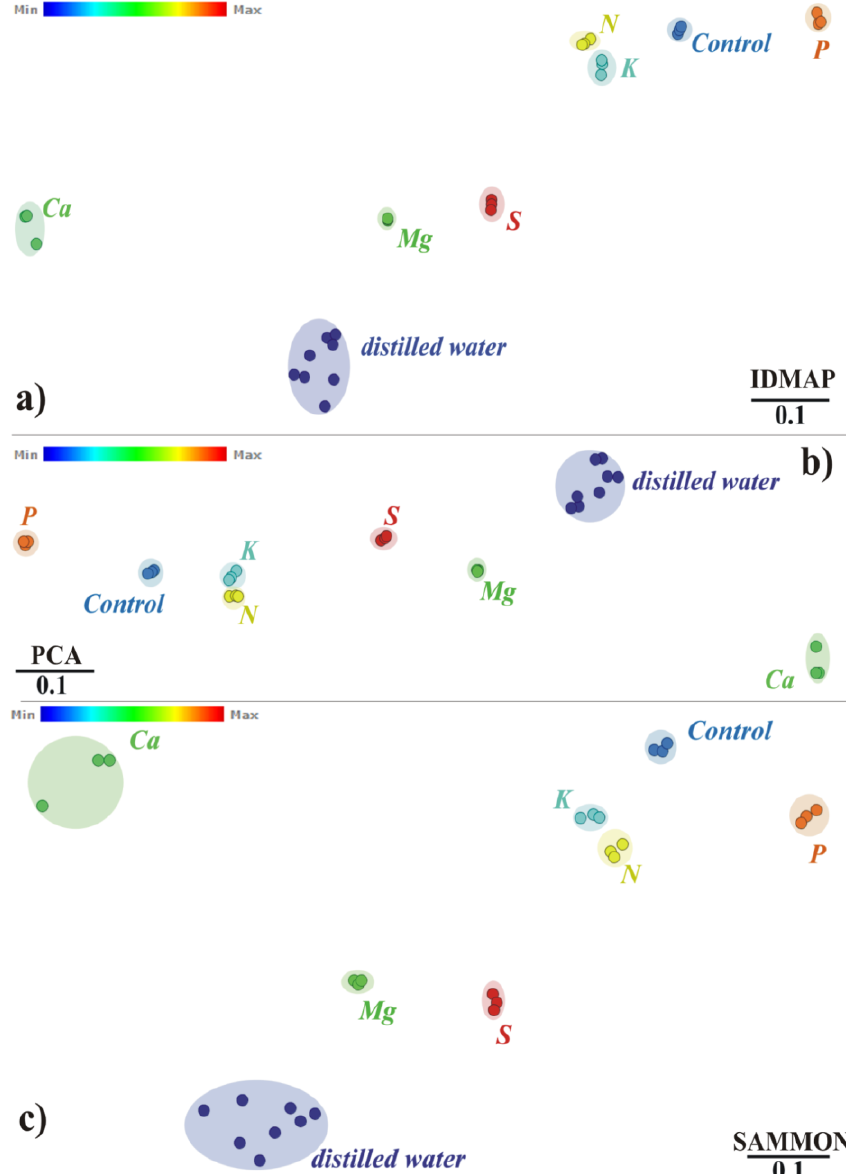
Figure 5. ( a ) IDMAP; ( b ) PCA and ( c ) SAMMON plots of capacitance data with selected frequencies